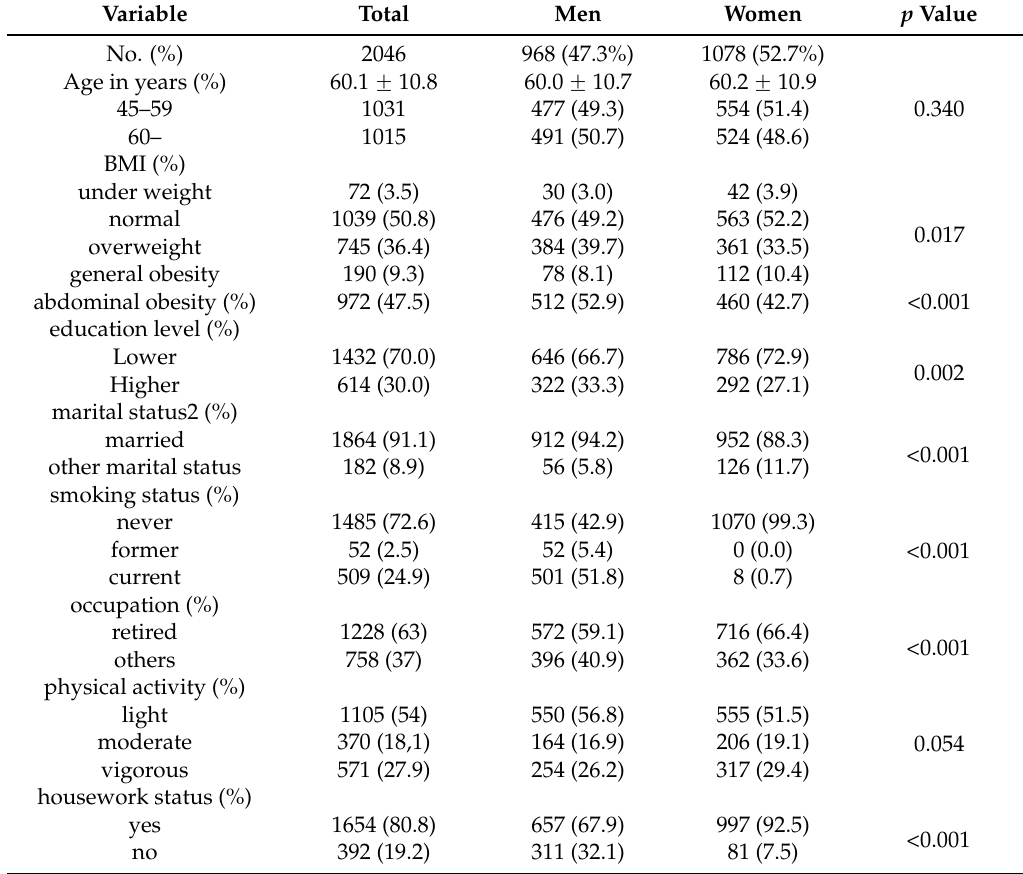
Table 2. Characteristics of the study